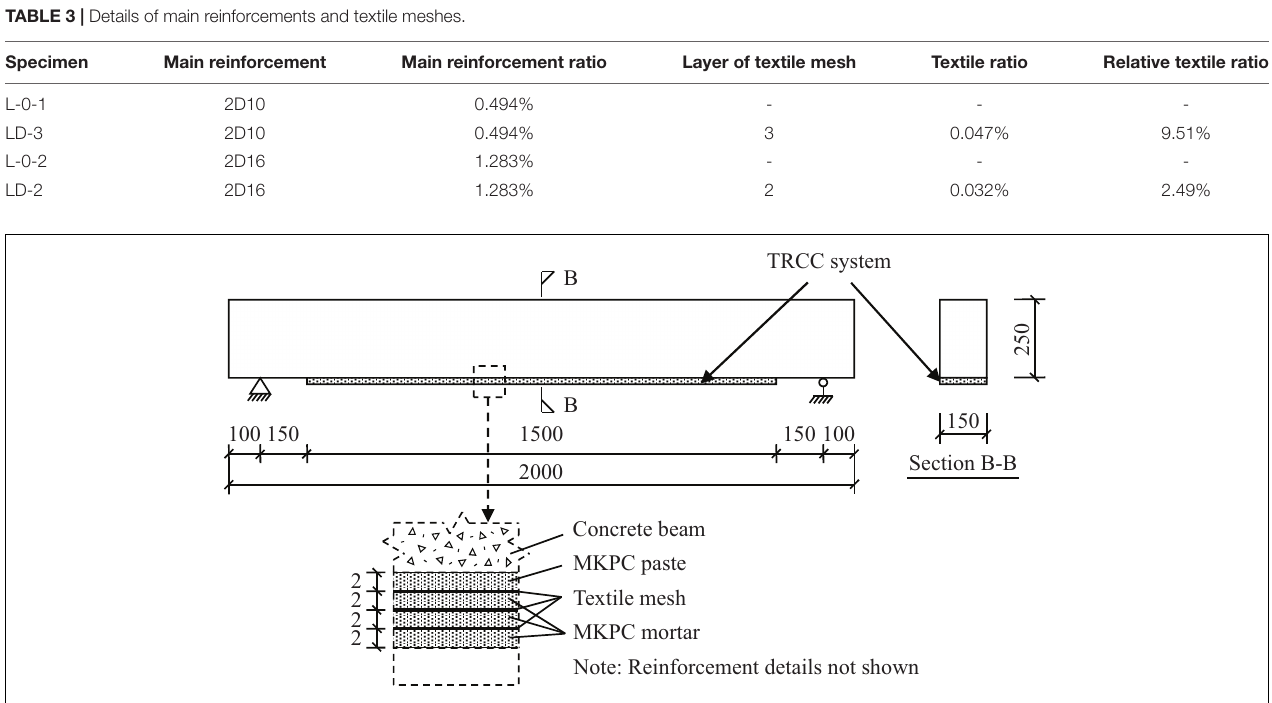
FIGURE 1 | Schematic view of specimen L-0-2 (unit: mm). TABLE 3 | Details of main reinforcements and textile meshes.